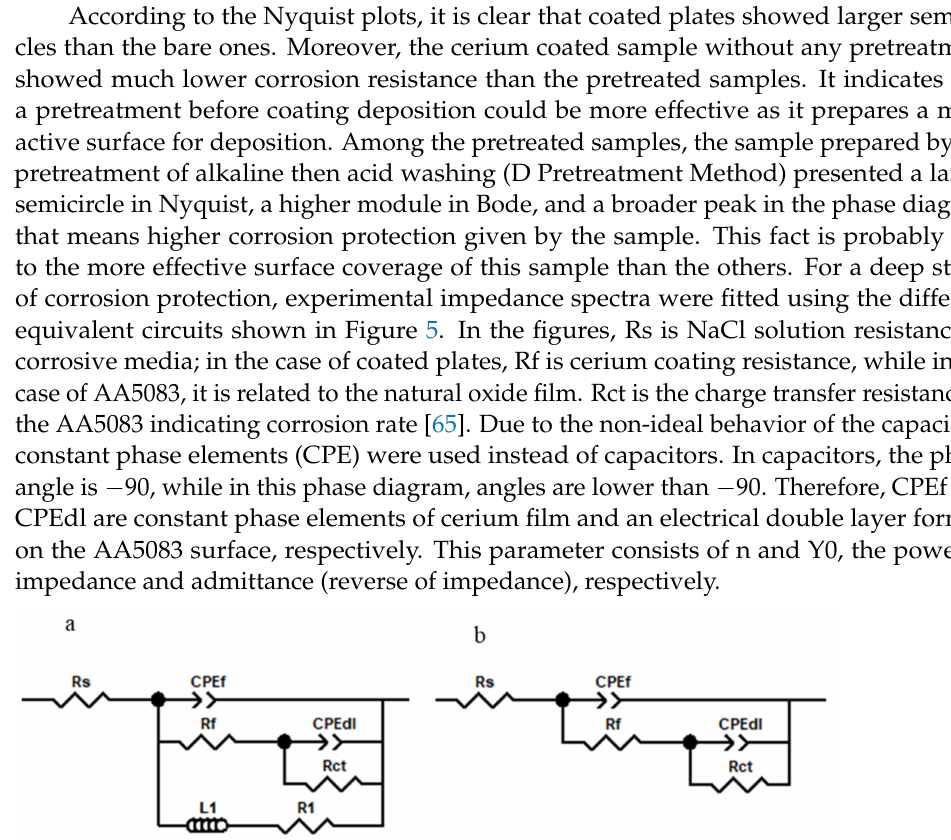
Figure 4. Typical ( a ) Nyquist, ( b ) Bode and ( c ) phase diagrams of cerium coated Al 5083 samples in 3.5 wt.% NaCl corrosive solution provided by different pretreatment conditions.